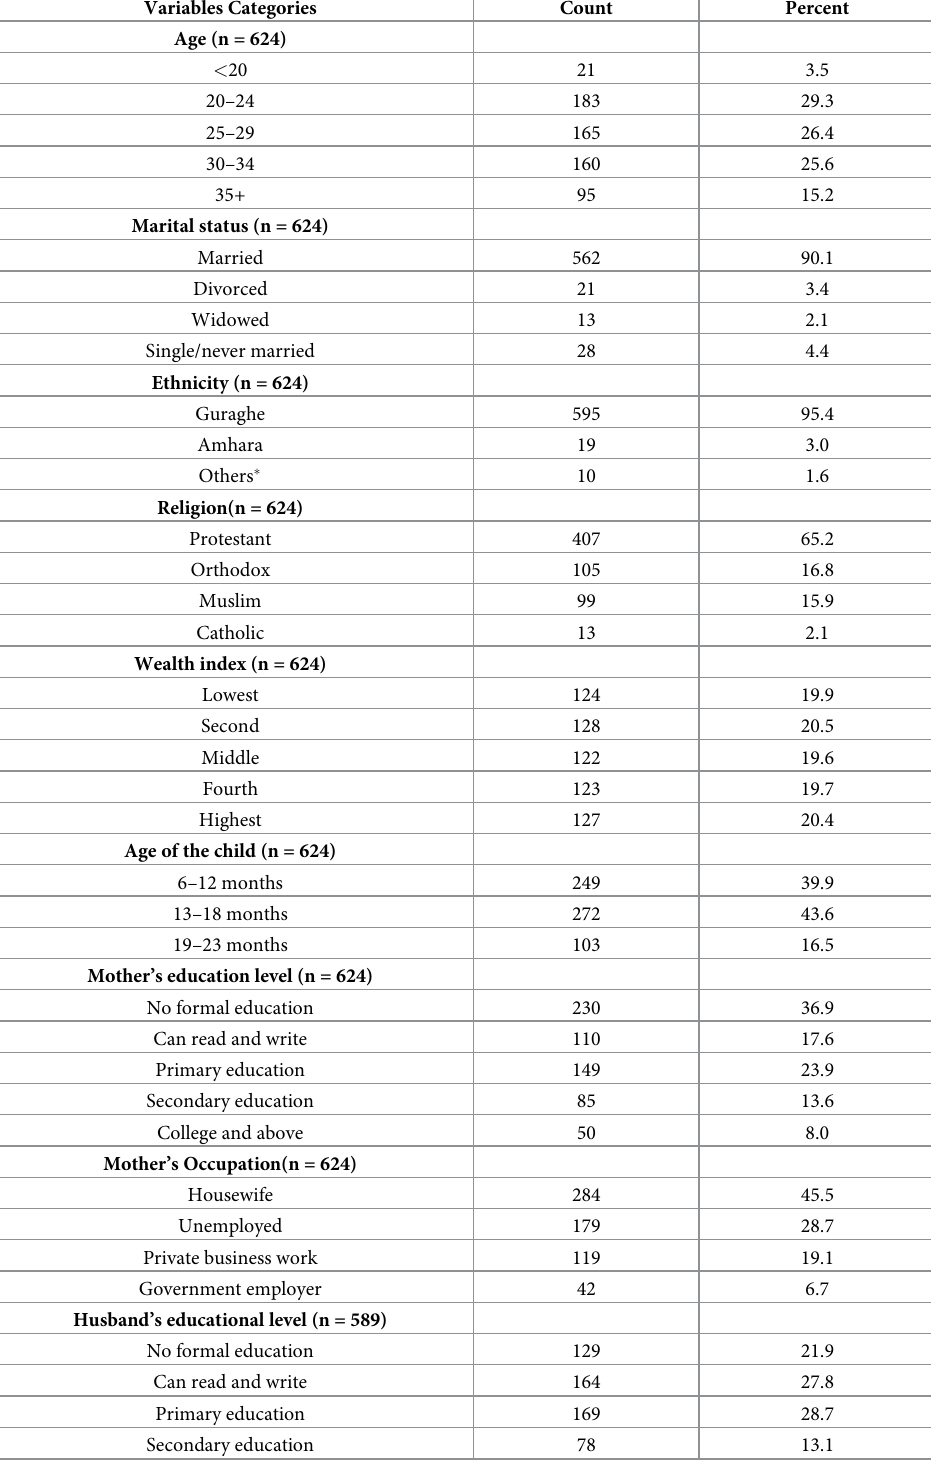
Table 1. Socio-demographic characteristics of mothers of children aged 6–24 months old in Lemo District, South- ern Ethiopia,